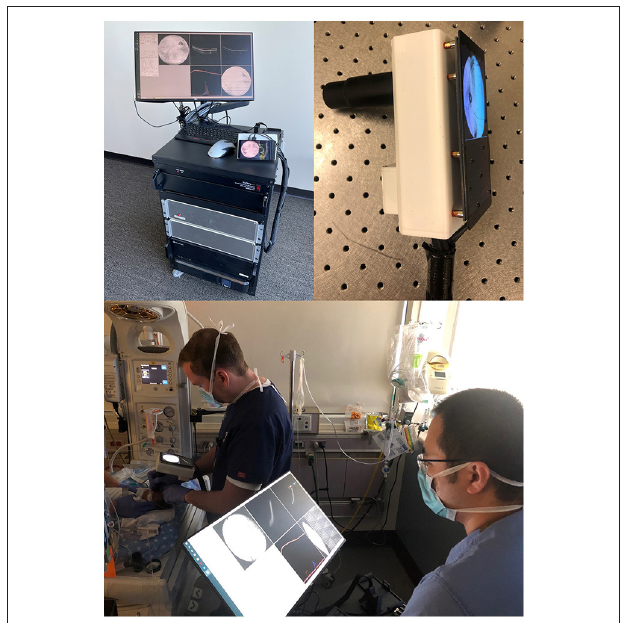
FIGURE 1 | Portable handheld OCT device. Upper-left image shows the prototype device with OCT module and computer. Upper-right image shows a close-up of the probe with a 5.5-inch display capable of real-time en face visualization. Bottom image shows the imaging process of an infant in the neonatal intensive care